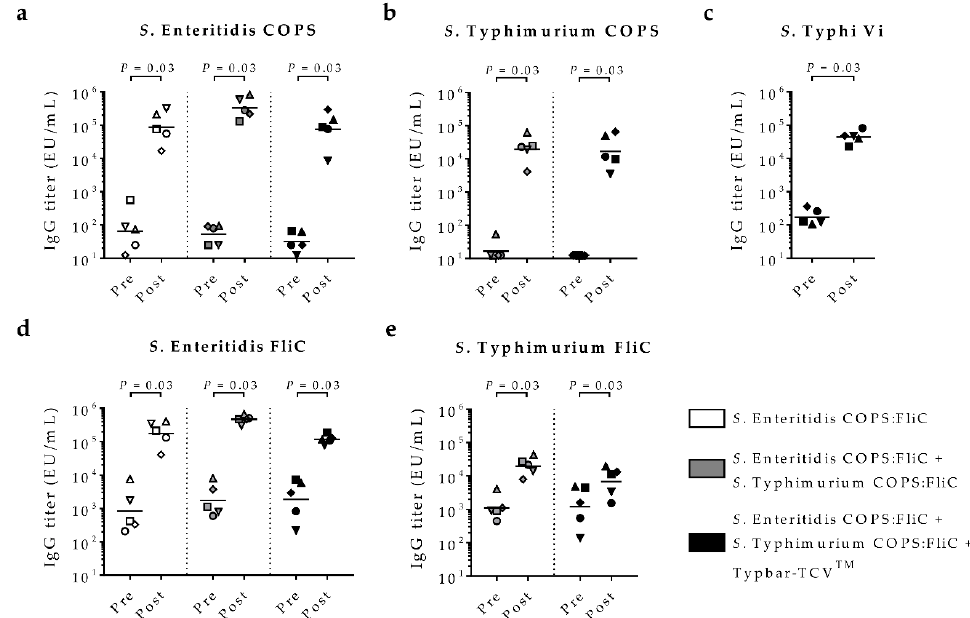
Figure 2. Serum IgG responses in rabbits immunized with Salmonella conjugate formulations. New Zealand White rabbits ( n = 5/group) were immunized intramuscularly with monovalent S . Enteritidis coupled core-O polysaccharide (COPS) and phase 1 flagellin protein (FliC) (COPS:FliC) (white shapes), a bivalent nontyphoidal Salmonella (NTS) co-formulation ( S. Enteritidis COPS:FliC + S . Typhimurium COPS:FliC, grey shapes), or a trivalent typhoid-iNTS co-formulation ( S . Enteritidis COPS:FliC + S . Typhimurium COPS:FliC + S . Typhi Typbar-TCV™, black shapes). Baseline or day 14 post-third immunization sera were assessed for IgG titers by ELISA against ( a ) S . Enteritidis COPS; ( b ) S . Typhimurium COPS; ( c ) S . Typhi Vi; ( d ) S . Enteritidis FliC; or ( e ) S . Typhimurium FliC. Points represent sera from individual rabbits, bars indicate the geometric mean titer. Comparisons between groups were accomplished by 1-tailed Wilcoxon matched-pairs signed rank test, for which p -values are indicated.